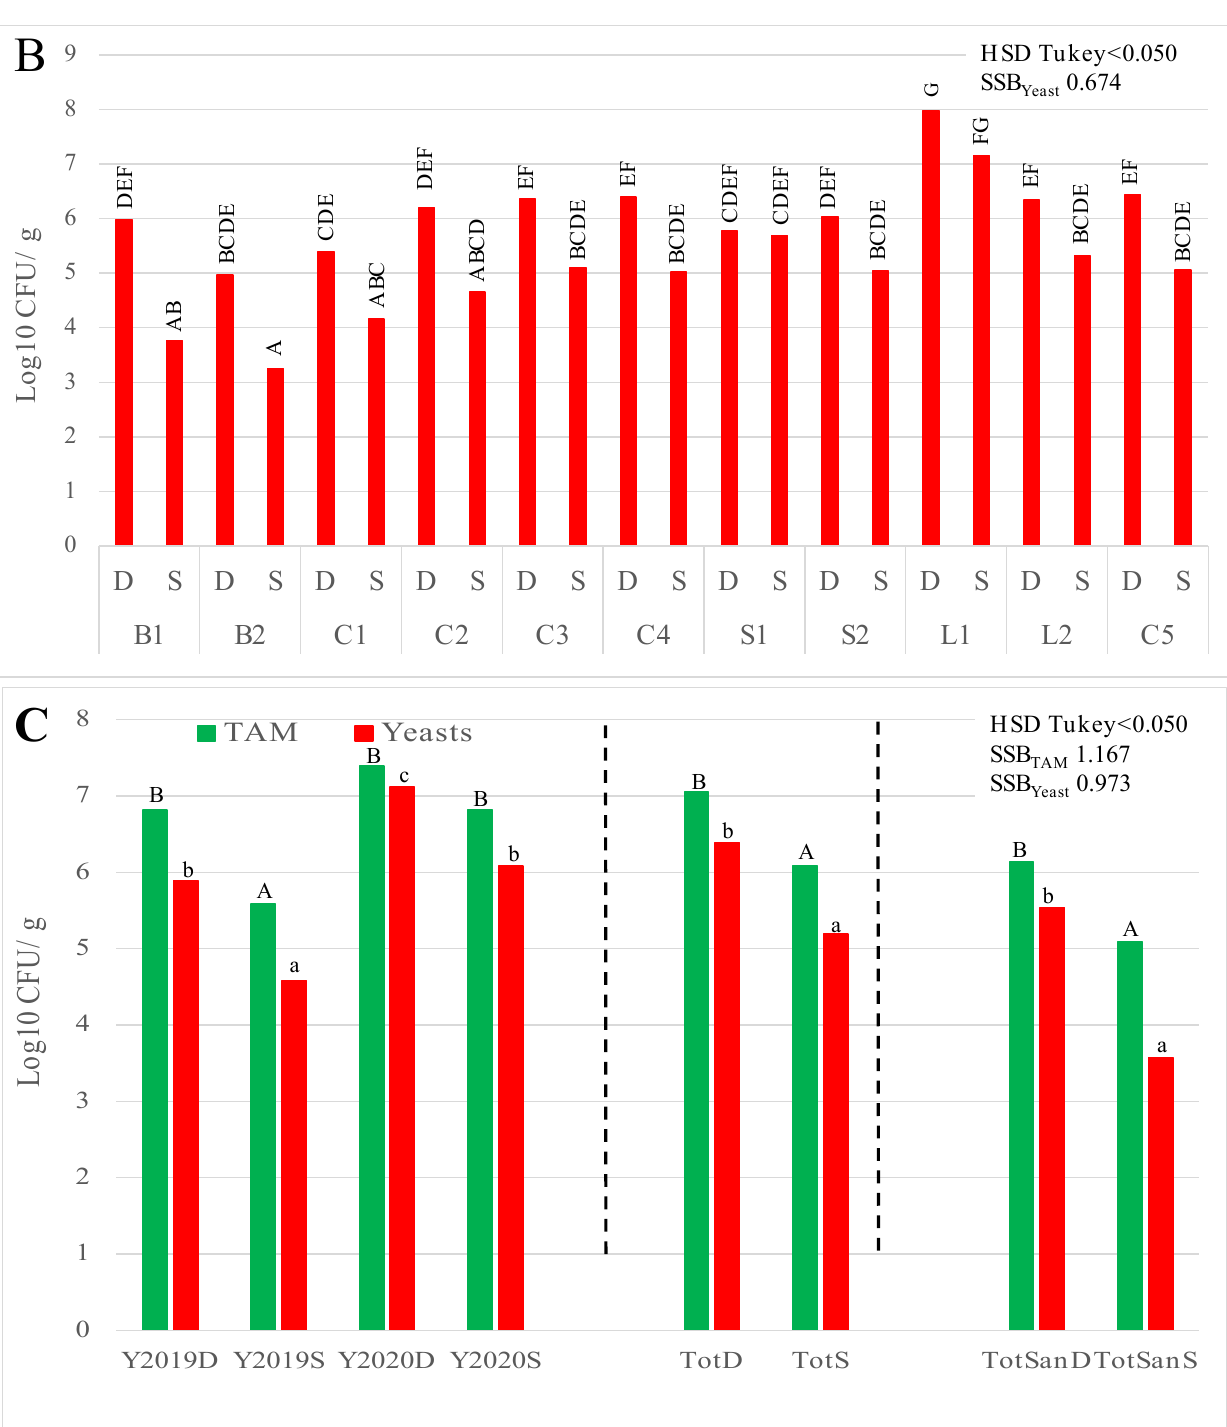
Figure 2. Counts of total aerobic mesophilic (TAM); ( A ) microorganisms and yeast ( B ) in damaged (D) and sound tissue (S) from ( A ) samples of cherries in 2019 (B1, B2, C1–C4, S1, S2) and 2020 (L1, L2, C5), and ( C ) mean counts by seasons: total counts by type of tissue (TotD: total counts on damaged tissues and TotS: total counts on sound tissues) and total counts by type of tissue after sanitisation with sodium hypochlorite (TotSanD: total counts on sanitized damaged tissues and TotSanS: total counts on sanitized sound tissues). Bars with different upper-case letters for TAM and lower-case letter for yeast indicates statistical differences ( p < 0.050). B, C, S, and L represents ‘Burlat’, ‘California’, ‘Sweetheart’, and ‘Lapins’ sweet cherry cultivars, respectively. HSD Tukey: Honestly Significant Difference; SSB: Statistical Significance Bar.